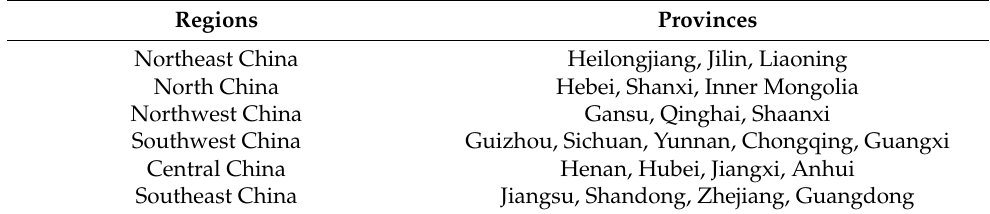
Table 3. Regional distribution of hog production in 22 sample provinces. Regions